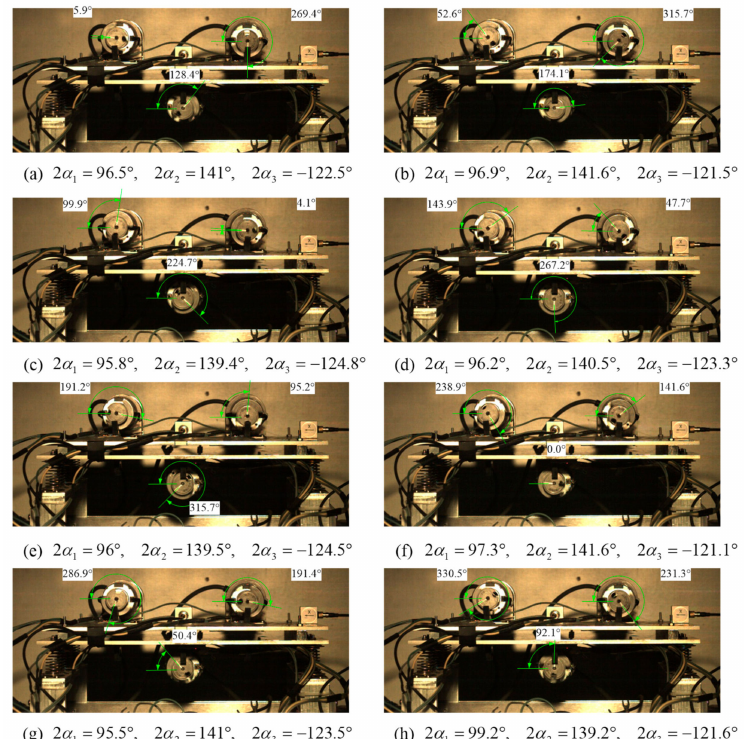
Figure 12. The phase difference of vibration synchronization of three ERs in the clockwise rotational direction. ( a – h ) are photos of continuous time intervals of 200 Hz.